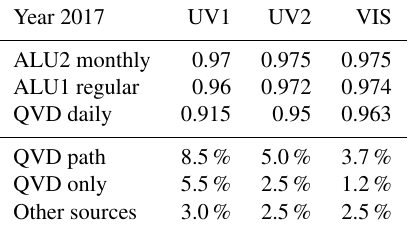
Table 3. Thresholds for clipping radiance and irradiance (given in their corresponding units) in the left and right parts of the three bands. Region UV1 UV2 VIS Radiance left 2 . 0 × 10 − 12 1 . 0 × 10 − 11 1 . 2 × 10 − 11 Radiance right 2 . 0 × 10 − 13 8 . 0 × 10 − 11 5 . 8 × 10 − 12 Irradiance left 2 . 0 × 10 − 10 Irradiance right